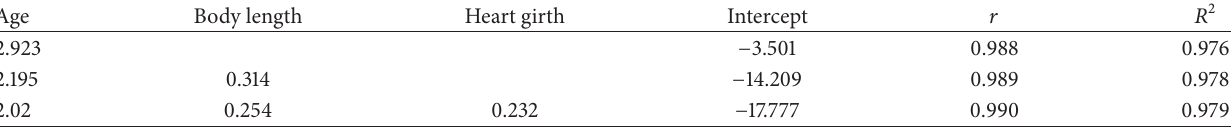
Table 4: Stepwise multiple linear regression prediction of live weight from body measurements ( 𝑛 = 156 ).